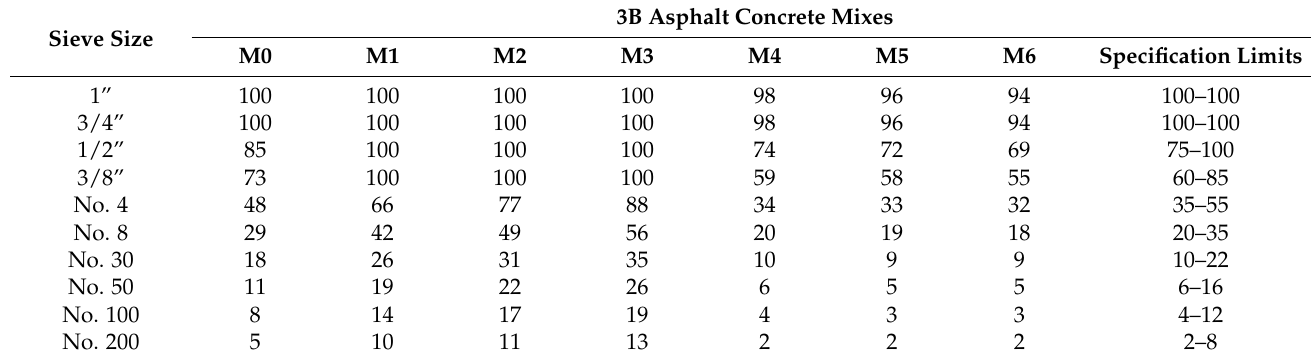
Table 3. Different gradations of asphalt concrete mixes.